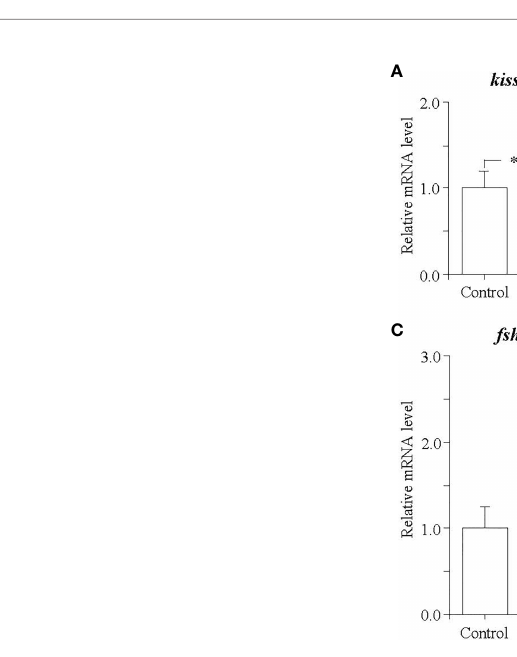
FIGURE 7 | Changes in the relative mRNA levels of kissr2 (A) , gpa (B) , fshb (C) and lhb ( D ) in the pituitary of grass puffer at regressed stage after intraperitoneal injection of gpKiss2 for the period of 12hrs. Values are presented as mean ± SEM (n = 6 − 7). Asterisks denotes a signi fi cant difference between the control and gpKiss2 injected fi sh (*, p <